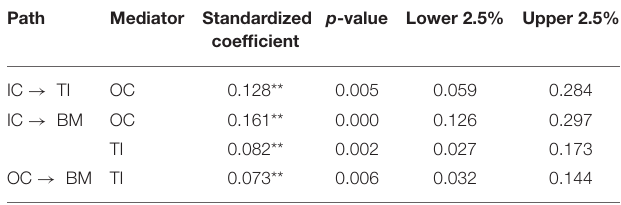
TABLE 6 | Coefficients of mediating effects.